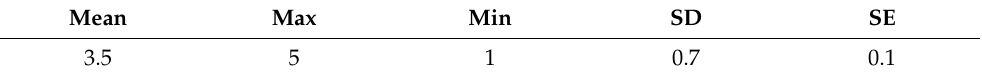
Table 12. Descriptive statistics for items regarding the effects of emotional messages.